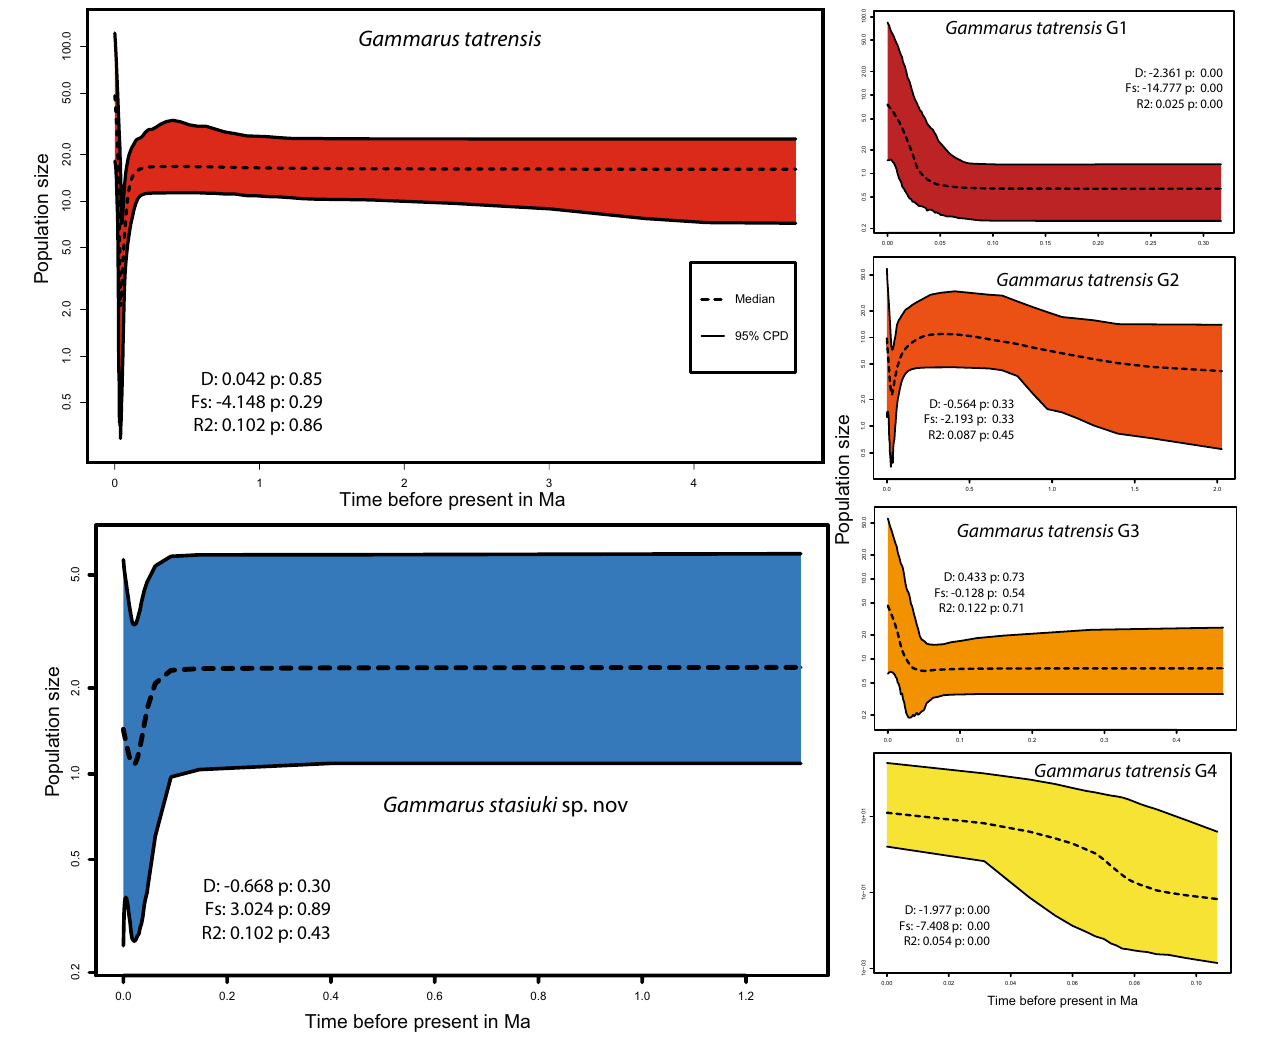
Figure 3. Demographic history of G. tatrensis and G. stasiuki sp. nov. represented through extended Bayesian skyline plots (eBSP) based on COI. Neutrality tests presented on figure: Tajima’s D, Fu’s Fs and Ramos-Onsins and Rozas’s